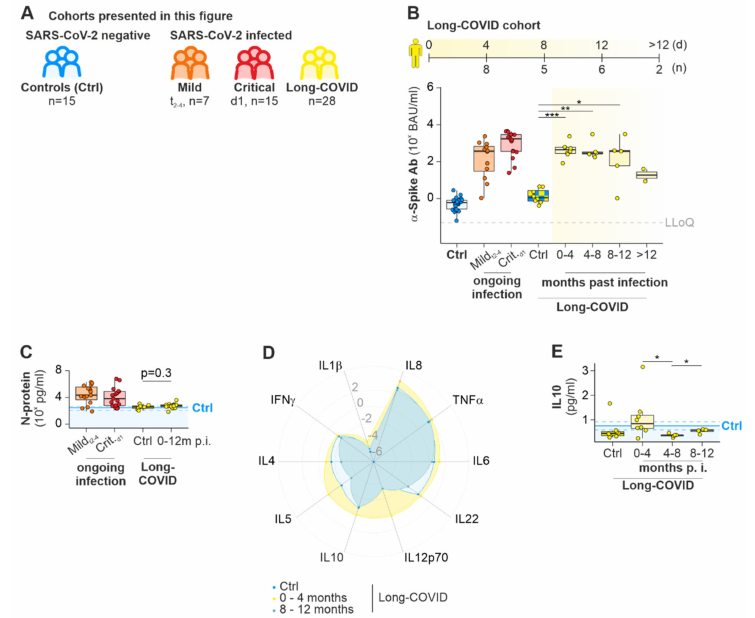
Figure 2. Dynamics of Ab titers against Wuhan SARS-CoV-2 Spike-protein and cytokines in Long-COVID. ( A ) Scheme of patient cohorts presented in the figure. ( B ) Comparison of α -Spike-Ab titers of included Long-COVID volunteers after various timepoints of infection to healthy controls, patients with a mild and critical COVID-19 disease course, as well as Long-COVID controls. ( B – E ) Characterization of the Long-COVID cohort by α -Wuhan-Spike-Ab ( B ), N-protein ( C ), normalized cytokine titers in a radar plot ( D ), and IL10 titers ( E ). Ctrl denotes a cohort of patients with similar symptoms but without a positive SARS-CoV-2 test. Blue line, mean concentration in healthy Ctrl; blue dashed line, 95% confidence interval; LLoQ, Lower Level of Quantification; Mann-Whitney U test; * p Val < 0.05, ** p Val < 0.01, *** p Val <